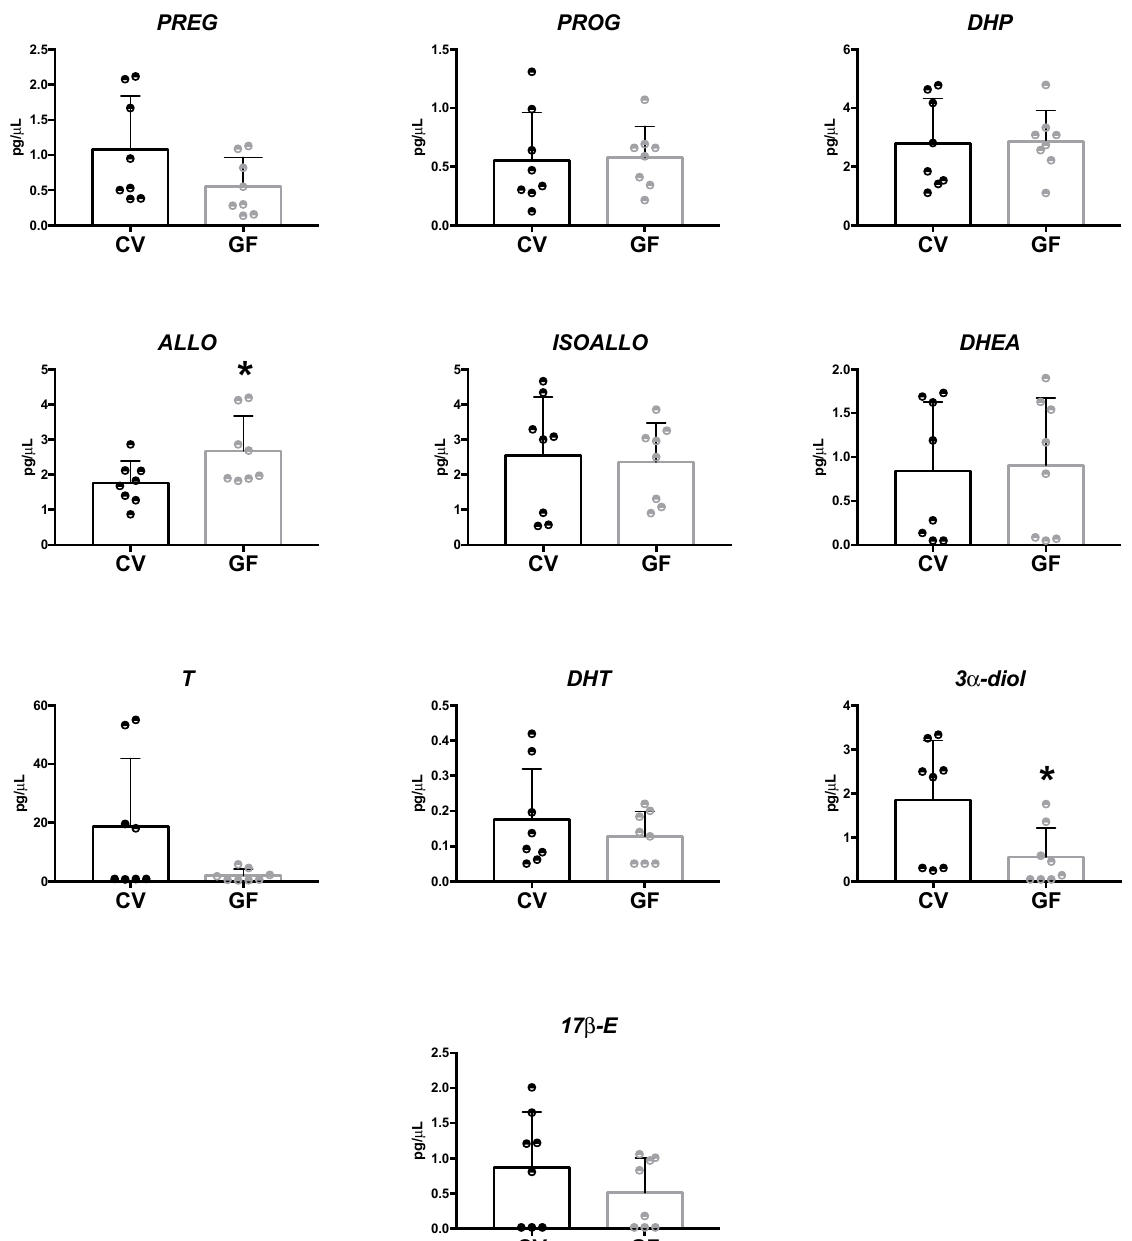
Figure 1. Levels of neuroactive steroids in the plasma of germ-free (GF) and conventional (CV) male mice. Data are expressed as pg/ µ L ± SD, n = 8 for each group. Unpaired Student’s t -test analysis: * p < 0.05 vs. CV mice.